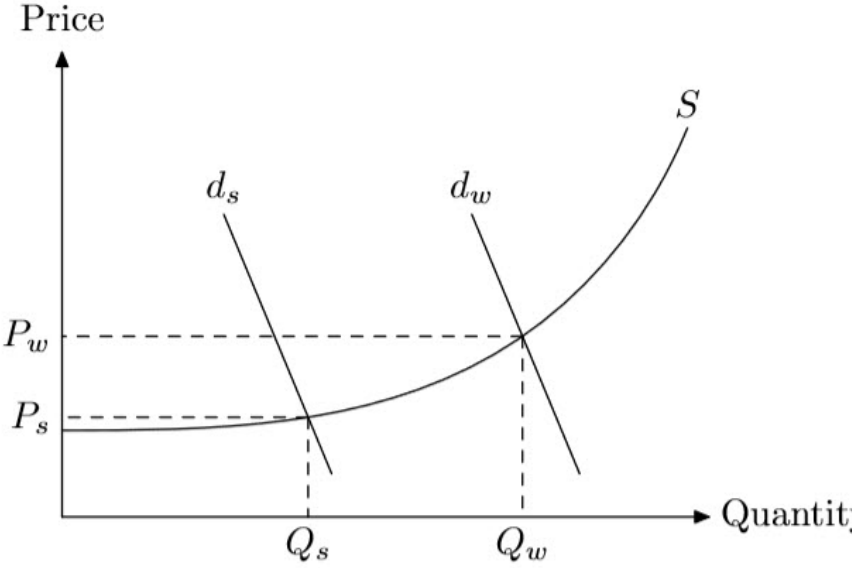
Figure 10. The demand for electricity summer ( d s ) and winter ( d w ) .